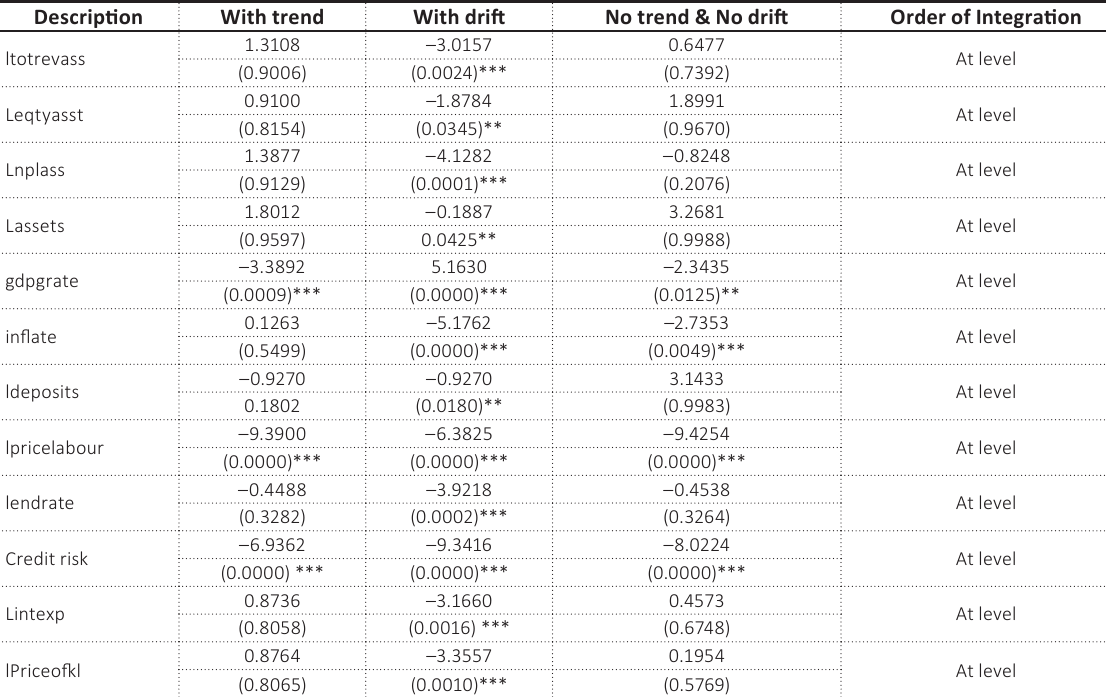
Table 3. Panel unit root